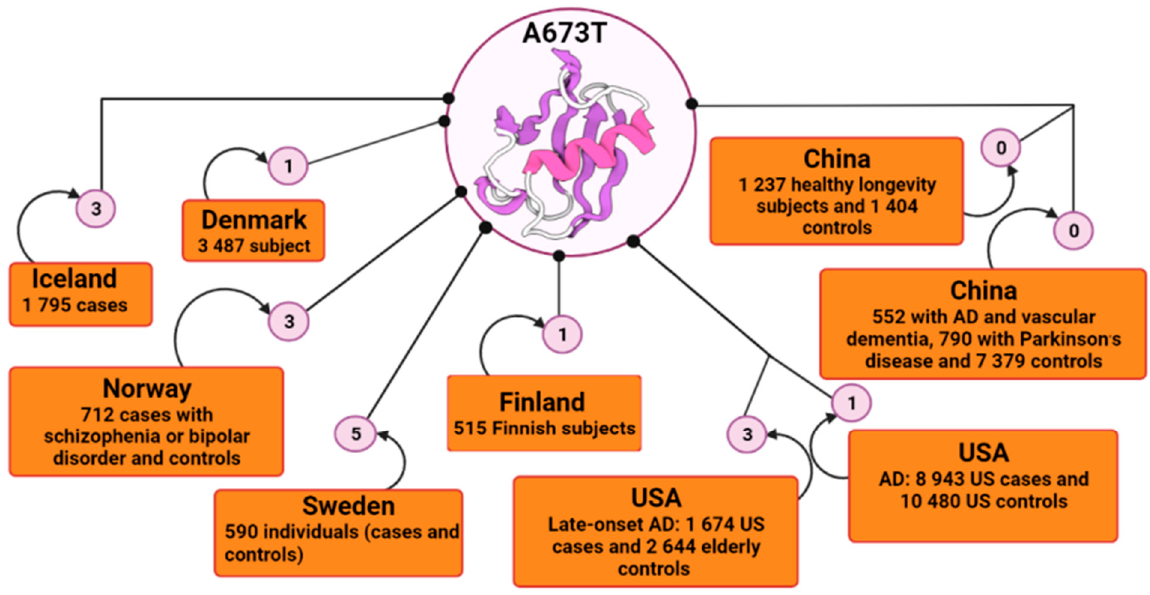
Figure 1. Schematic representation of the incidence of A673T mutation by country using BioRender. In the Icelandic population, the frequency of the A673T mutation was reported to be 0.13% in AD cases and up to about 0.70% in controls. In other large-scale studies, frequencies were reported to be 0.51% for Finnish subjects with AD, 0.42% for Swedish, 0.21% for Norwegian, 0.014% Danish and 0.011% for American; and 0.018% for cognitively normal controls. The A673T mutation appeared to be absent in a screen of 8721 Asian individuals, and in 2641 healthy longevity Chinese subjects. AD, Alzheimer’s disease; USA, United States of America.